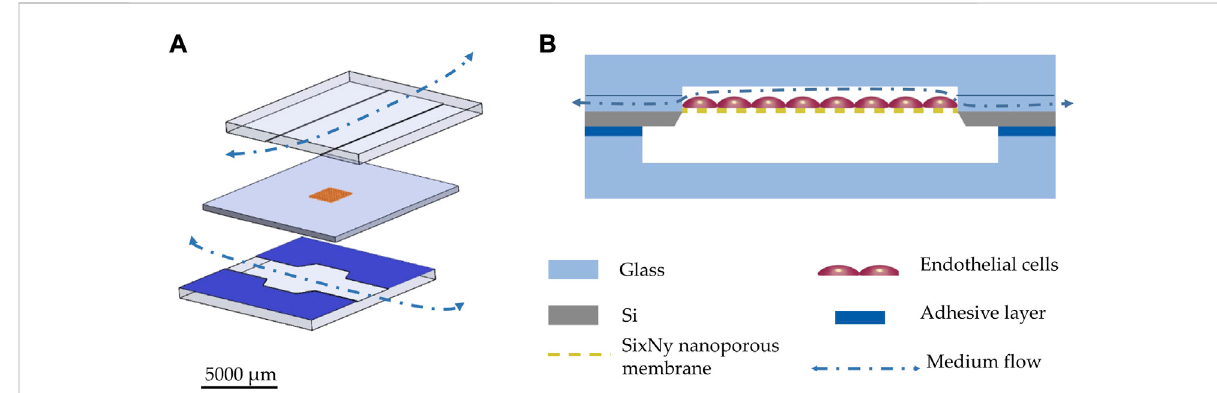
FIGURE 3 (A) 3DexplosiondrawingoftheOOCsystem:thetopandbottomglasslayersarecomprisingwetchemicallyetched100 µmdeepchannels;the middle layer comprises a silicon frame, which is holding the Si x N y membrane with dry etched nanopores. The bottom glass layer is coated with a silicone rubber fi lm as adhesive sealing layer (ARcare ® 90106NB). (B) schematic cross-section of the